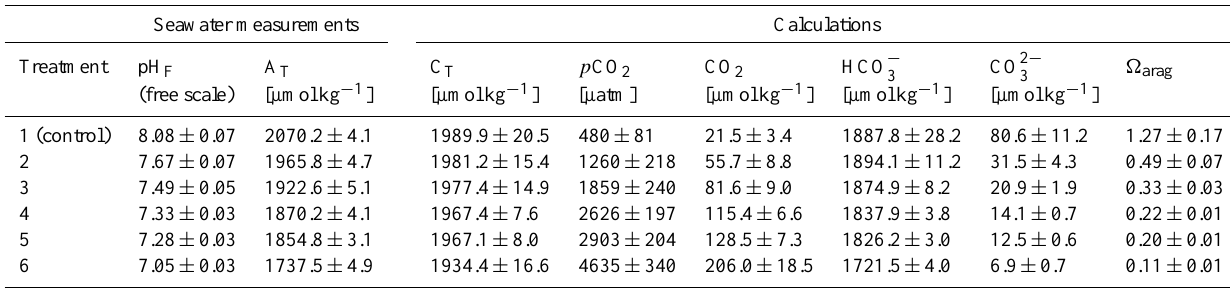
Table 1. Seawater carbonate system speciation for the different treatment levels during the course of the experiment. Variables were calculated using measured pH F , A T , salinity (14.0) and temperature (13.6 ± 0.4 ◦ C) of the respective replicates at the beginning, in the middle and at the end of the experiment. Values are means ±